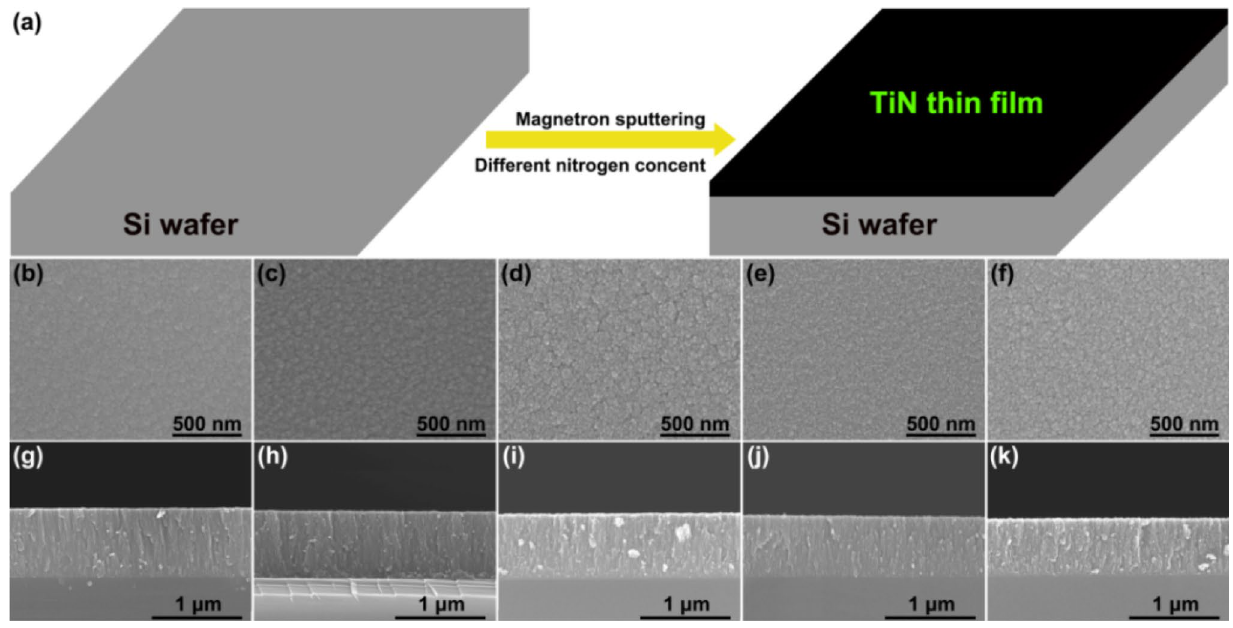
Fig. 2 a Schematic illustration of the fabrication process, b – f Surface morphologies and g – k Cross-sectional microstructures of TiN thin films